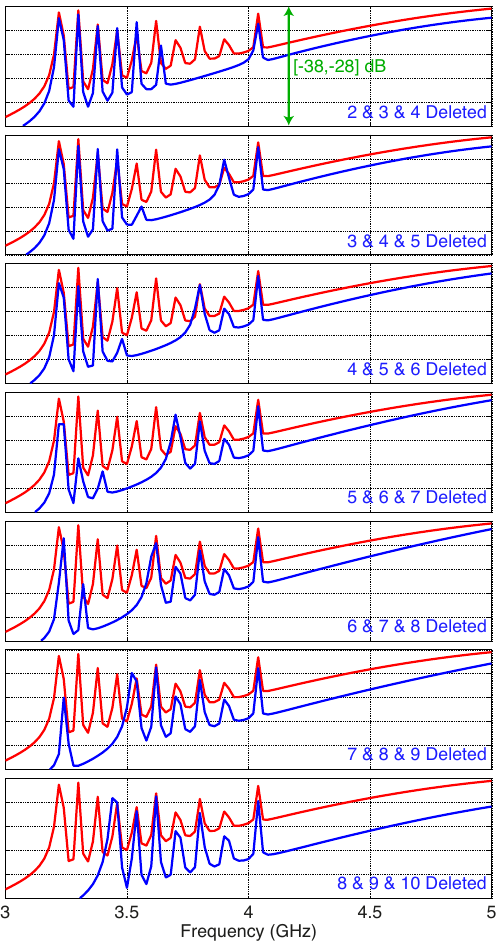
Figure 6: Electromagnetic responses of RFID tags that are obtained by deleting blocks of three bits from the overall structure in Fig.